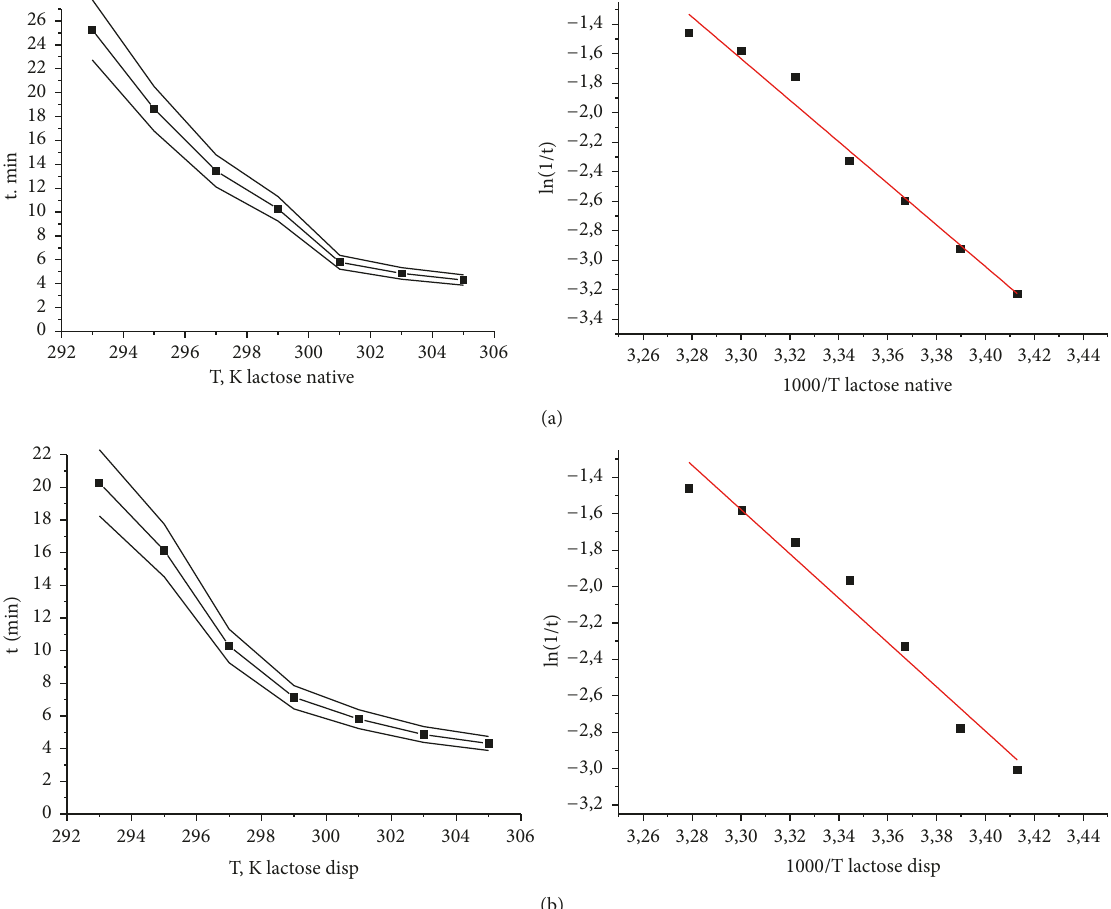
Figure 4: Dependence of the infusoria mortality rate on temperature and dispersity for the aqueous solutions of 7% lactose monohydrate in direct (left graph) and Arrhenius coordinates (right graph). (a) Native lactose and (b) dispersed lactose. n ≥ 5; a <